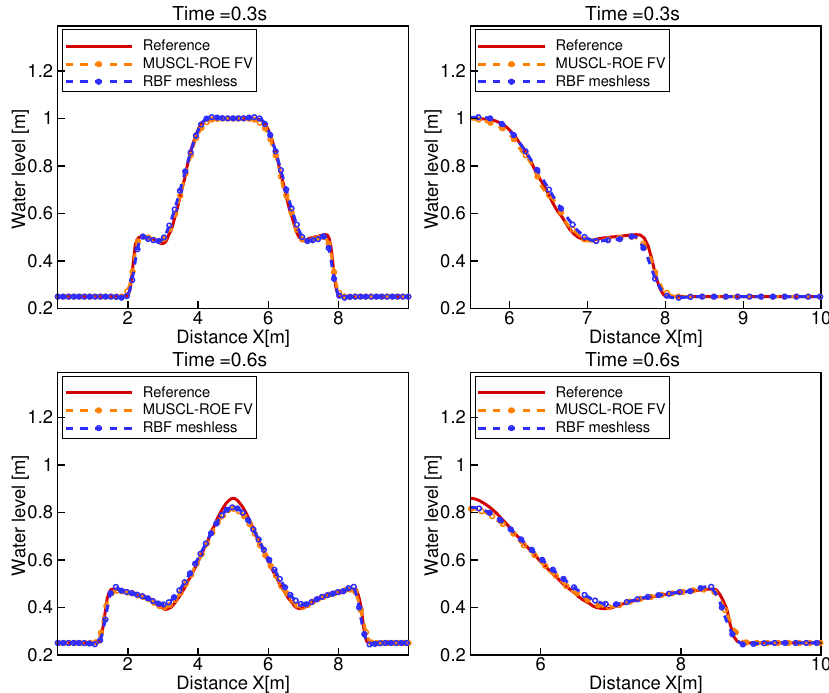
Figure 3. Comparisons of water level cross-sections at x = 5 m calculated using the Roe-MUSCL finite volumes method and the present LRBF meshless method at times t = 0.3 s and 0.6